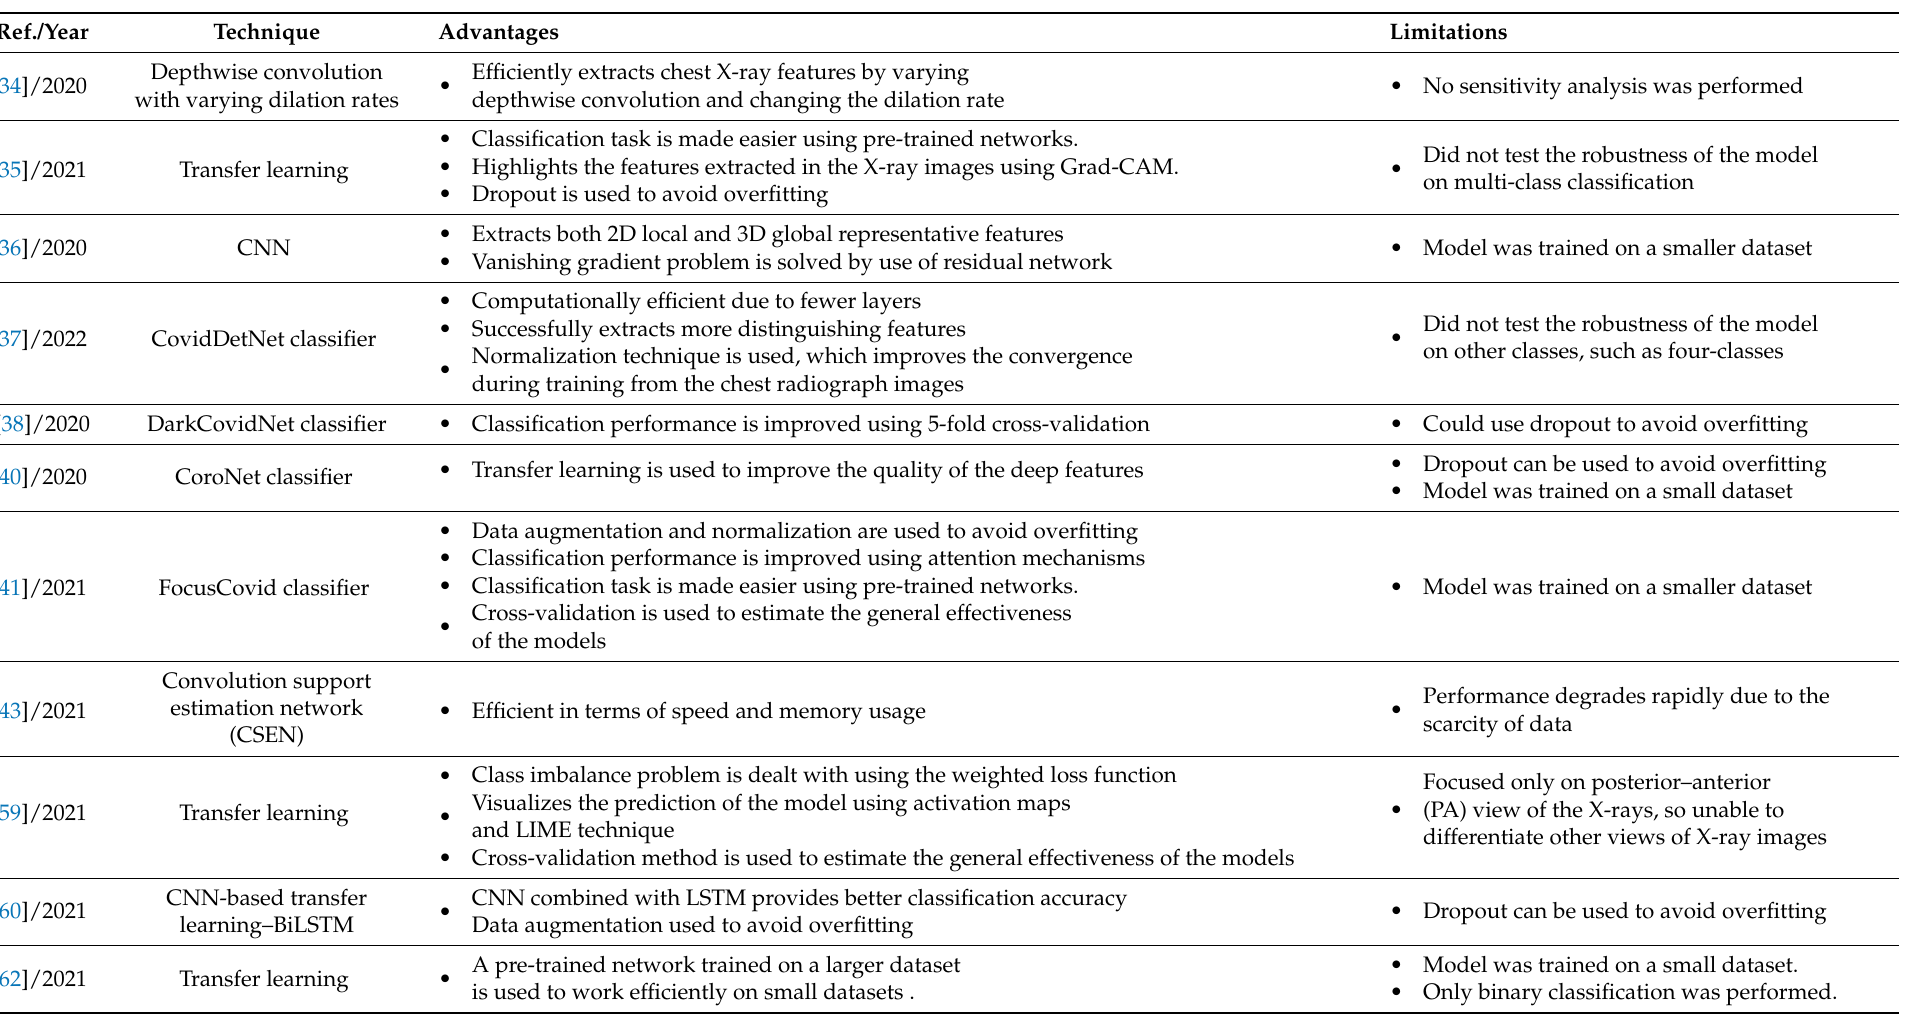
Table 1. Summary of related